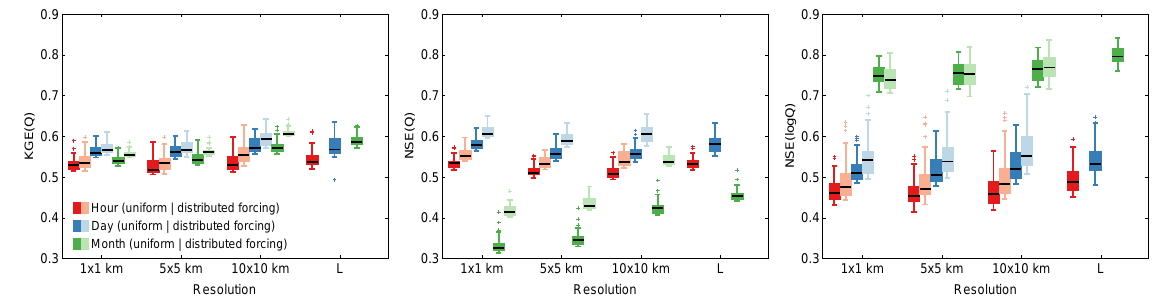
Figure 6. Model performance of the behavioural sets for different temporal resolutions and different spatial resolutions. The left panel shows the KGE( Q ), the middle panel the NSE( Q ) and the right panel the NSE(log Q ). Per objective function the most behavioural sets were selected; hence, the selected sets where not necessarily the same for the three objective functions. The box shows the 25th–75th percentiles. .